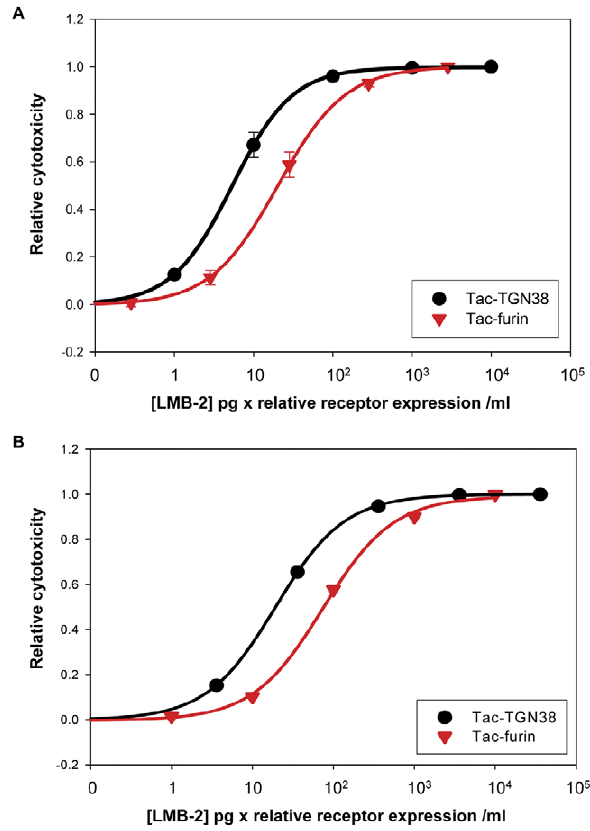
Figure 4. Comparison of cell toxicity at comparable levels of immunotoxin binding. Tac-TGN38 and Tac-furin cells were treated with the indicated dose of LMB-2. After a 24 hour incubation with immunotoxin, cells were washed, and the cells remaining in the well were used for A ) Hoechst-based cell count assay or B ) LDH assay as described in Methods. Panels A and B show the relative cytotoxicity plotted against the amount of LMB-2 adjusted to reflect the different Tac expression levels (Figure 3C) in the cell lines ([LMB-2] 6 Tac expression). Here the cytotoxicity has been normalized so that a value of 1 represents the maximum killing observed with the highest dose of LMB-2 for each cell line (relative cytotoxicity). The data points represent the cytotoxicity values averaged over several experiments, cell count assay (n=9), LDH assay (n=8). The standard error of the mean is shown.